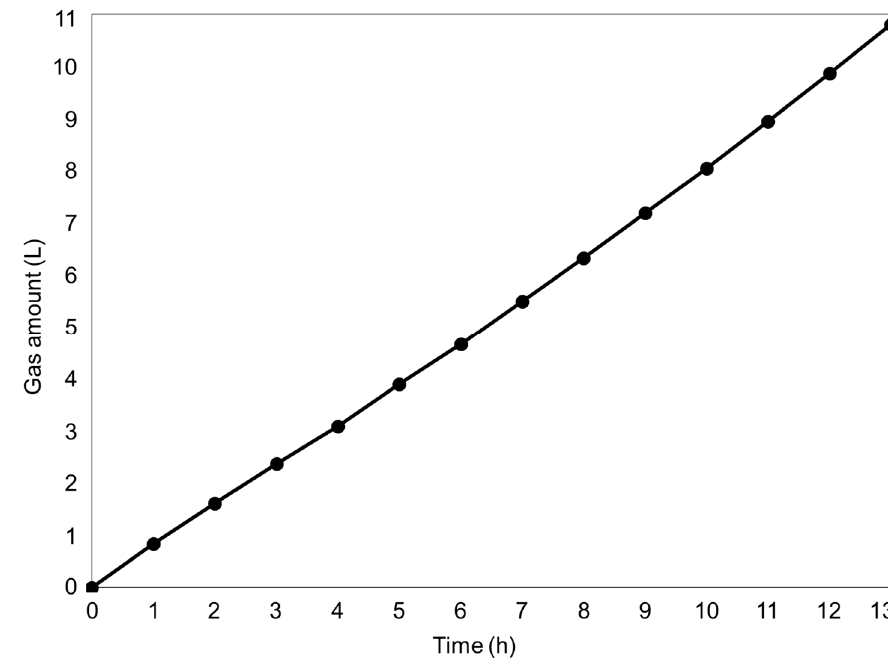
Figure 2. Time course study of long-term dehydrogenation of 2-PrOH. The reaction was carried out under the conditions described in Scheme 3.